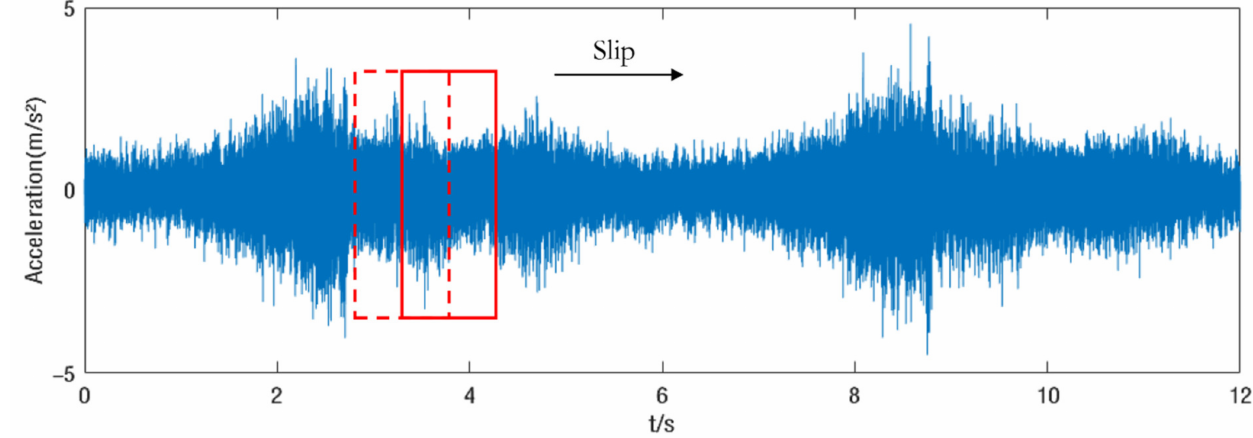
Figure 10. Vibration data collected by one of the acceleration sensors.